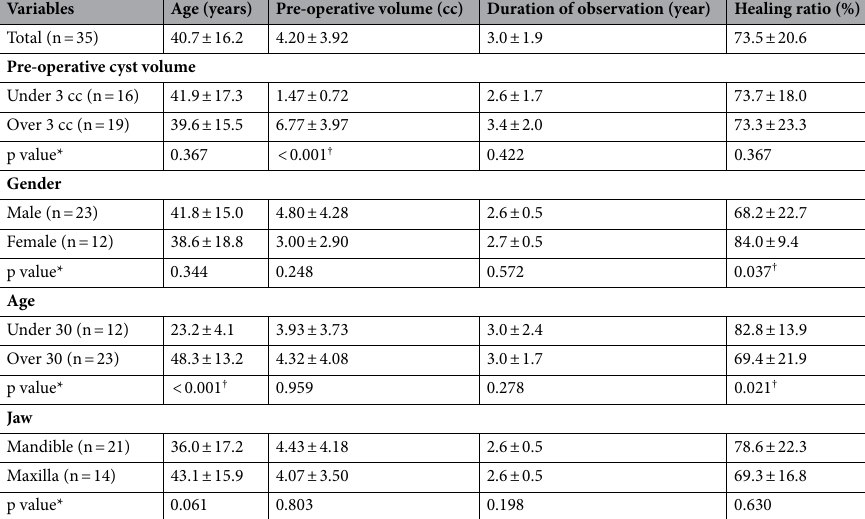
Table 3. Volumetric analysis for spontaneous bone healing for long-term follow-up group (≥ 1 year). *Mann– Whitney U test. † p value < 0.05.